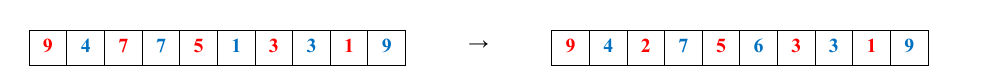
Figure 10. Mutation operation in evolutionary hybrid